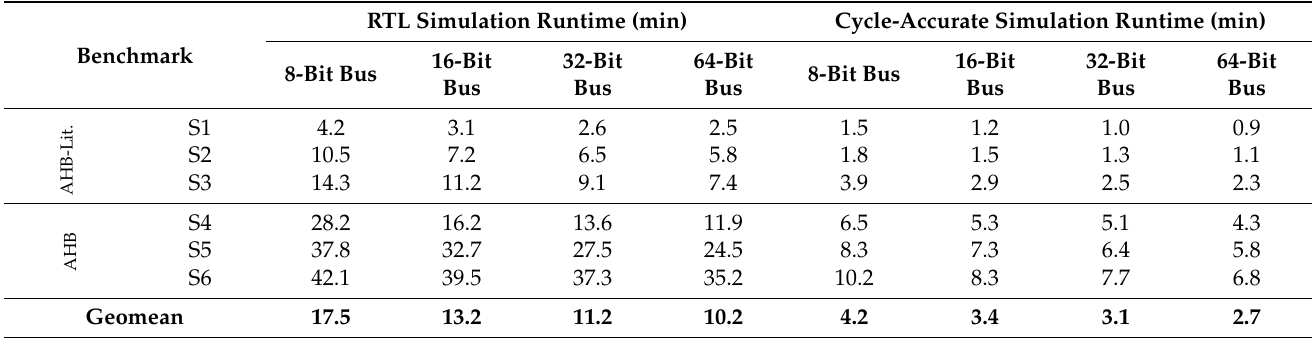
Table 7. Runtime comparison of RTL simulation vs. cycle-accurate simulation using our proposed approach.